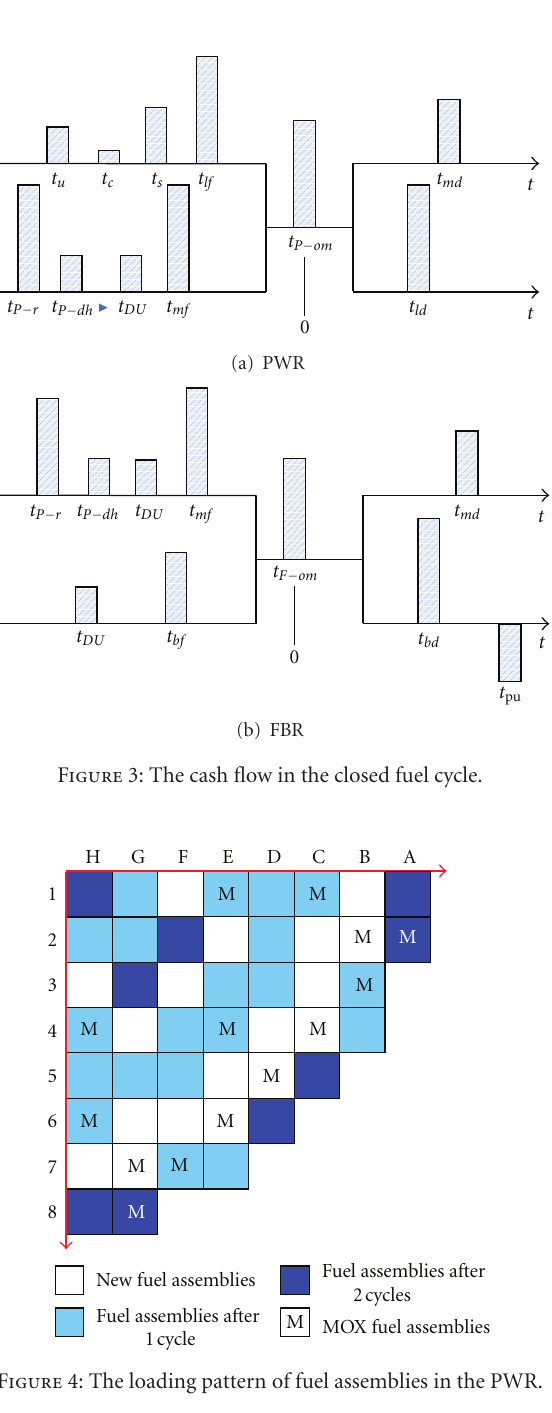
depleted uranium, breed the plutonium with small fraction